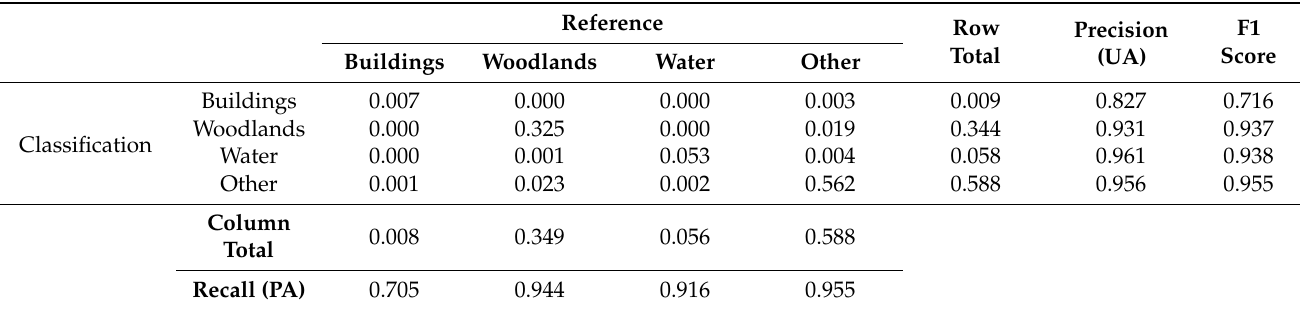
Table 7. Confusion matrix for semantic segmentation of LandCover.ai dataset. Values in the table represent estimates of the population (i.e., landscape) proportions. OA = 95.0%.